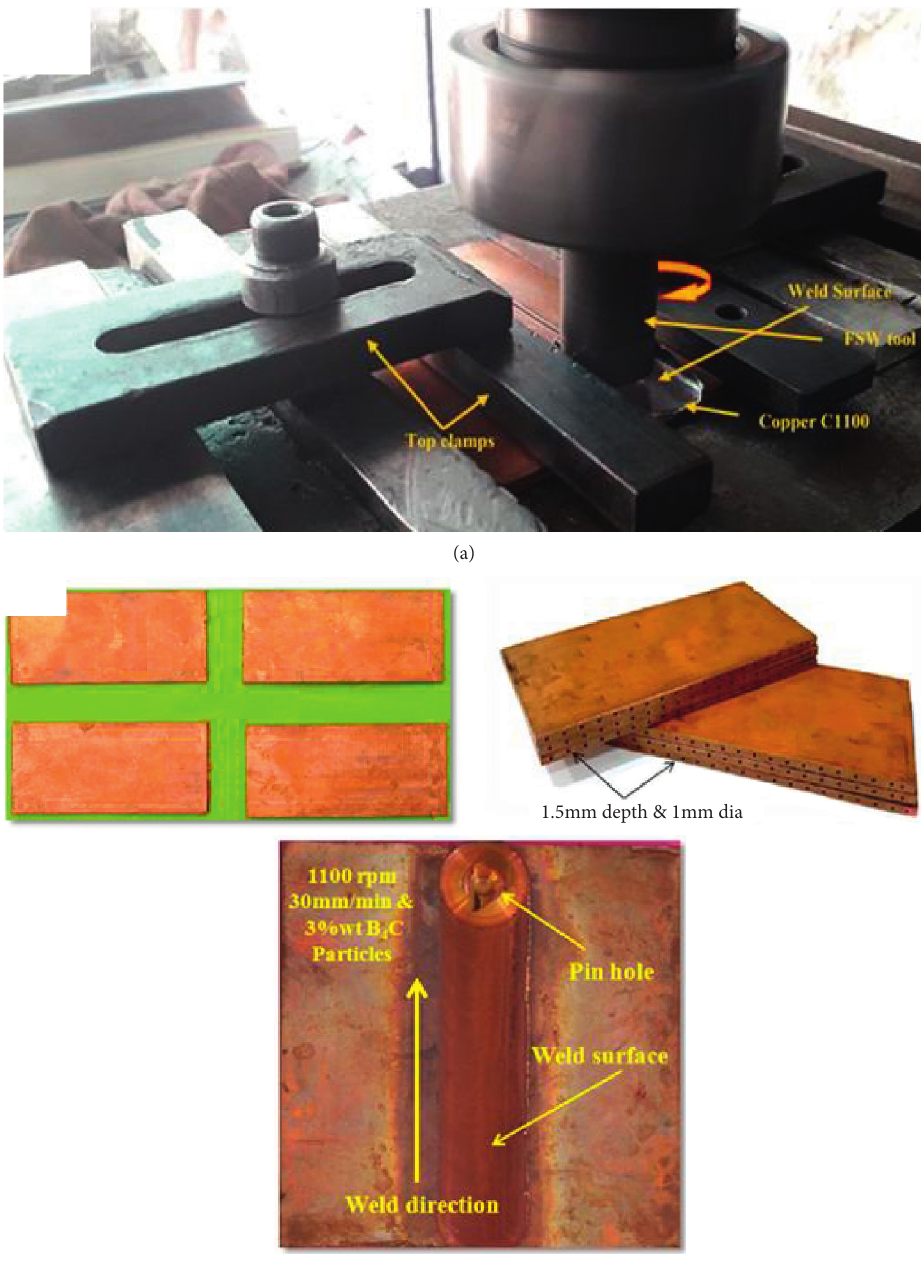
Figure 2: (a) Photographic view of the FSW process with inclusion of B